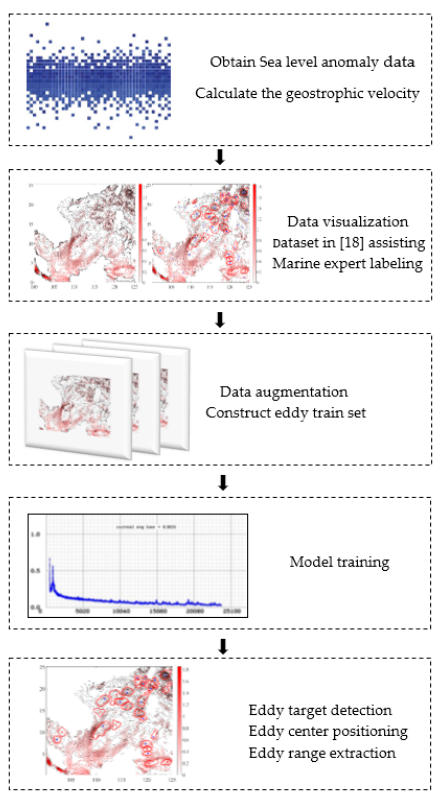
Figure 1. The flow chart of the proposed mesoscale eddy detection algorithm based on deep learning.